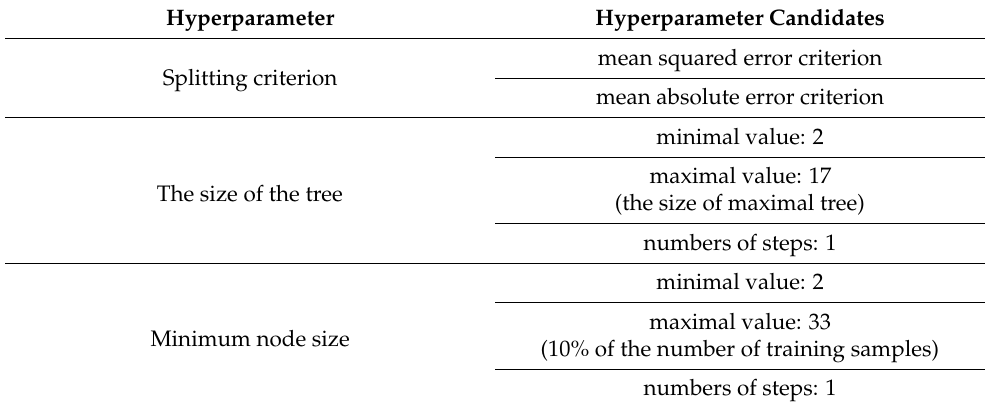
Table 3. The hyperparameter space of CART.